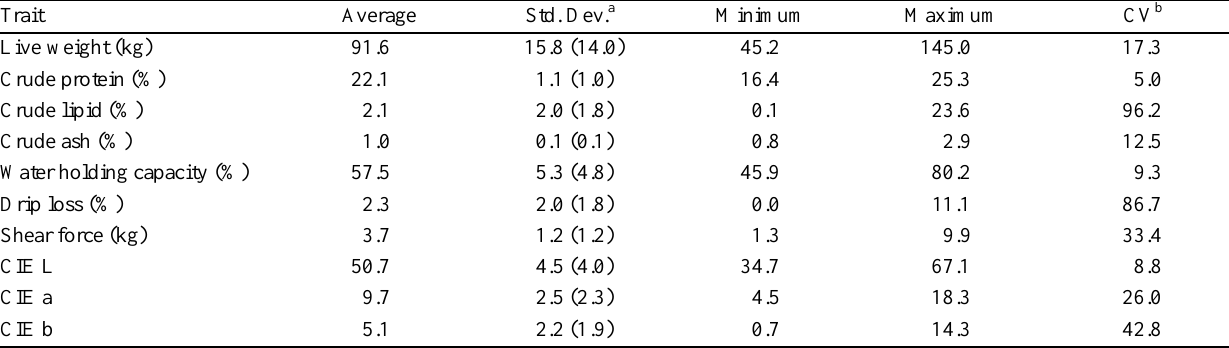
Table 1. Summary statistics for 490 F 2 phenotypes on meat quality in a KNP  LN cross